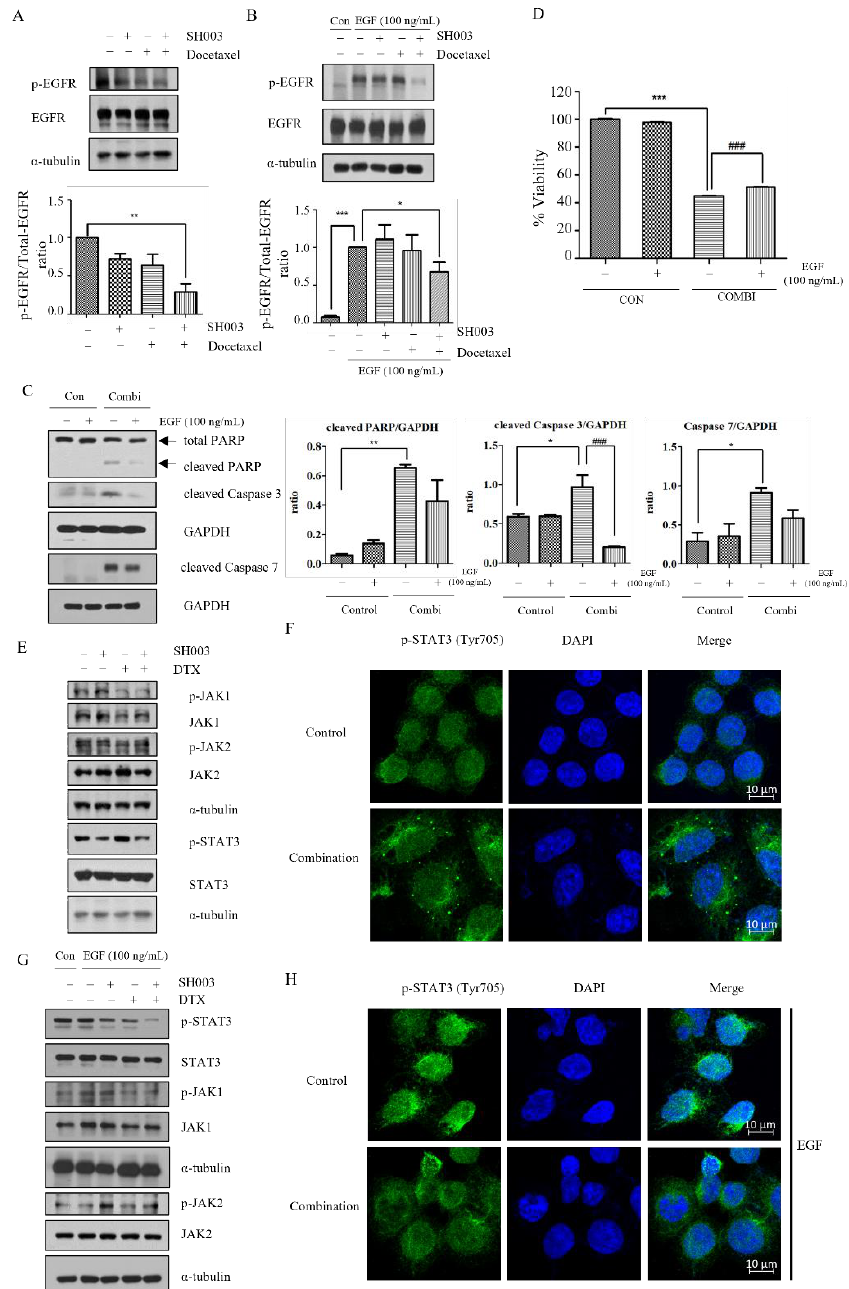
Figure 3. Combination treatment with SH003 and docetaxel downregulates the expression of p-EGFR and p-STAT3 in non-small-cell lung cancer. Lysates of H460 cells treated with 300 μg/mL SH003 or 1 nM docetaxel for 15 min were probed with the indicated antibodies. Further, α-Tubulin was used as the loading control. Quantification of proteins normalized to the control was performed, and the experiments were repeated three times. ( A – C ) Expression levels of proteins meas- ured using Western blotting. ( B – D ) H460 cells pretreated with 100 ng/mL EGF, followed by treat- ment with 300 μg/mL SH003 and 1 nM docetaxel. ( D ) Viability of H460 cells after combined treat- ment with SH003 and DTX, and 100 ng/mL EGF for 48 h. ( E , G ) Expression levels of several proteins, including p-STAT3 (Y705) and p-JAK1/2, determined by Western blotting without or with 100 ng/mL EGF. ( F ) Intracellular distribution and expression level of STAT3 in H460 cells determined by immunocytochemistry without EGF. ( H ) H460 cells pre-treated with EGF (100 ng/mL), and sub- sequently treated with SH003 and docetaxel, at concentrations identical to those used in Western blotting. Combination treatment inhibited the translocation of STAT3 to the nucleus. The results